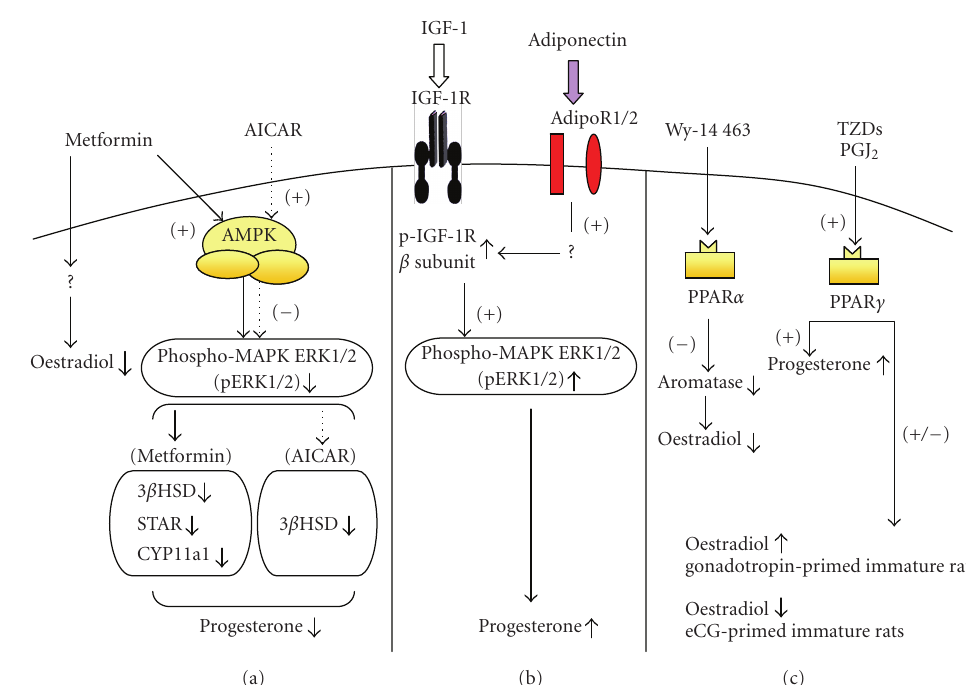
Figure 2: Schema illustrating the e ff ects of (a) metformin- or AICAR-induced AMPK activation, (b)adiponectin, and (c) TZDs or PPAR alpha ligands on the rat granulosa cell steroidogenesis. (a) Metformin or AICAR treatment decreases MAPK ERK1/2 phosphorylation and progesterone secretion through AMPK activation [60, 65]. Metformin decreases also oestradiol secretion through an independent AMPK pathway [60]. (b) Adiponectin treatment increases IGF-1-induced IGF-1R β -subunit tyrosine phosphorylation and MAPK ERK1/2 phos- phorylation and progesterone secretion [12]. (c) The PPAR α ligand, Wy-14 463, inhibits oestradiol secretion whereas TZDs or PGJ2 increases progesterone secretion and inhibits estradiol secretion in eCG-primed immature rats or increases estradiol secretion in gonadotropin- primed immature rat [23, 52]. 3 β HSD: 3 β -hydroxysteroiddehydrogenase, STAR: Steroidogenic acute regulatory protein, CYP11a1: P450 sidechain cleavage, Adipo R1/2: Adiponectin receptor type I and II, MAPK ERK1/2: Mitogen Activated protein kinase Extracellular Regu- lated kinase,1/2, PGJ2: prostaglandine